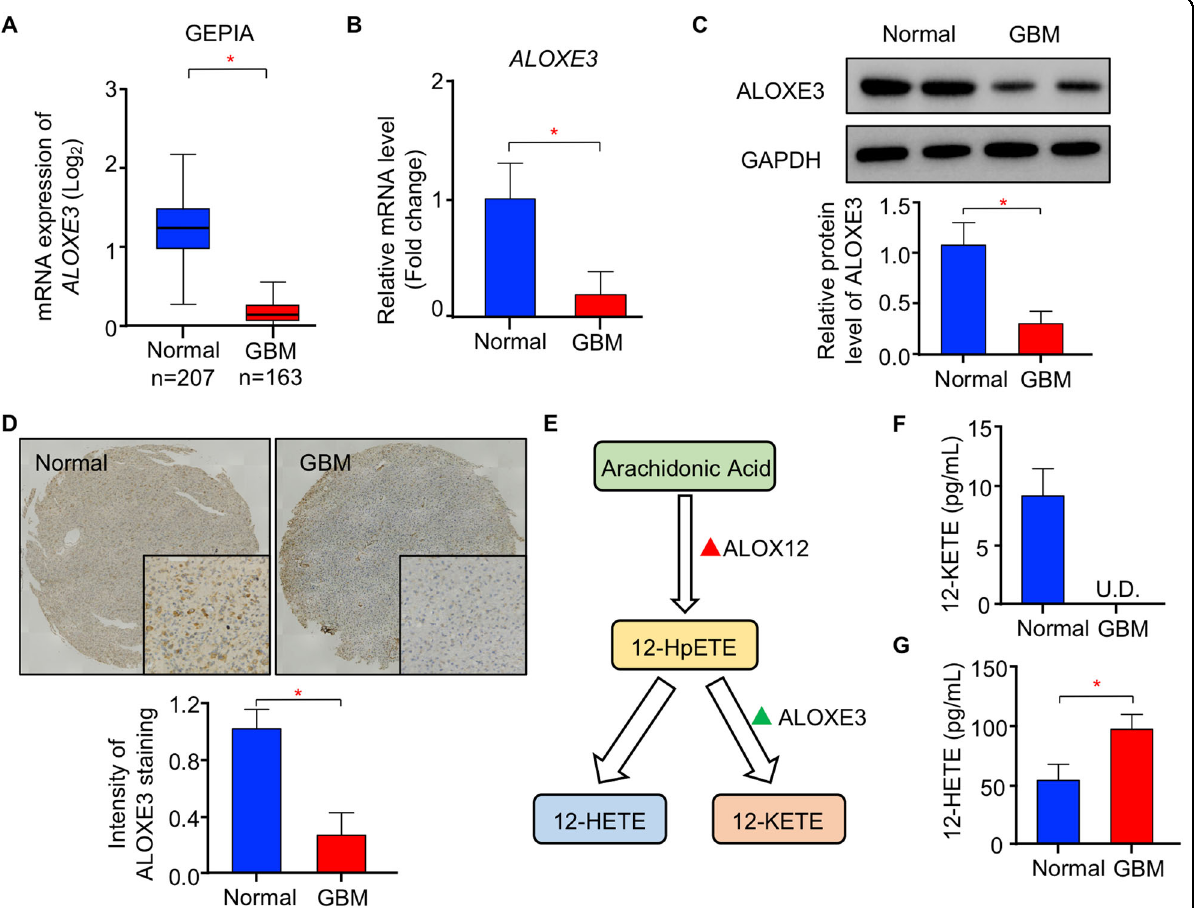
Fig. 1 Expression of ALOXE3 is down-regulated in human GBM. A GEPIA analysis of ALOXE3 mRNA level in open access datasets ( n = 207 for normal brain tissues and n = 163 for GBM). B , C Human GBM tissues and normal brain tissues were used ( n = 6). B Relative mRNA level of ALOXE3 normalized with GAPDH in human GBM tissues and normal brain tissues. The mRNA level is expressed as fold change over normal brain tissues. C Immunoblotting analysis of ALOXE3 and GAPDH in human GBM tissues and normal brain tissues. Representative immunoblot images are shown. The bar chart is the relative expression level of ALOXE3 normalized with GAPDH. D Immunohistochemistry staining of ALOXE3 in human GBM tissue microarray ( n = 8 for normal brain tissue and n = 19 for GBM). E Diagram of arachidonic acid metabolism catalyzed by ALOXE3. F , G Circulating levels of ( F ) 12-KETE and ( G ) 12-HETE in the cerebrospinal fl uid of GBM patients ( n = 10). All data are represented as the mean ± s.e.m. * p < 0.05 (Student ’ s